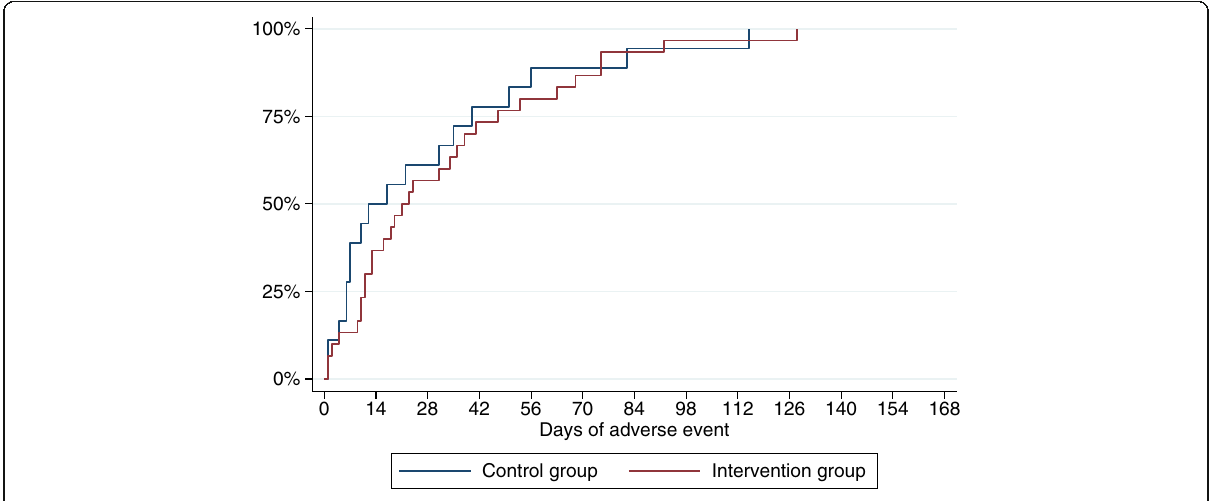
Fig. 3 Duration of grade 2 or higher adverse